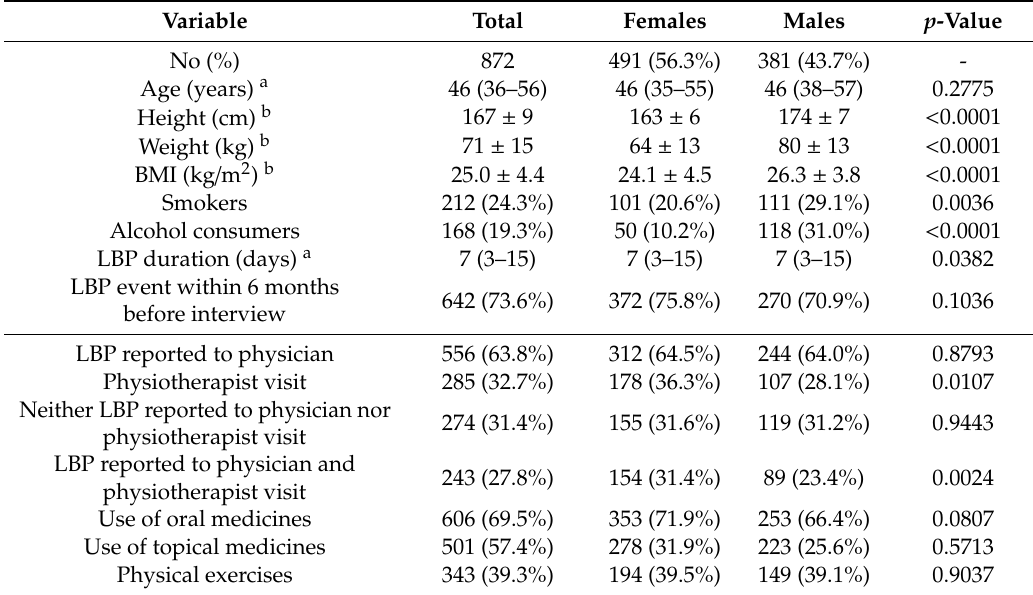
Table 1. Demographics of the study population at baseline and patients’ attitudes in low back